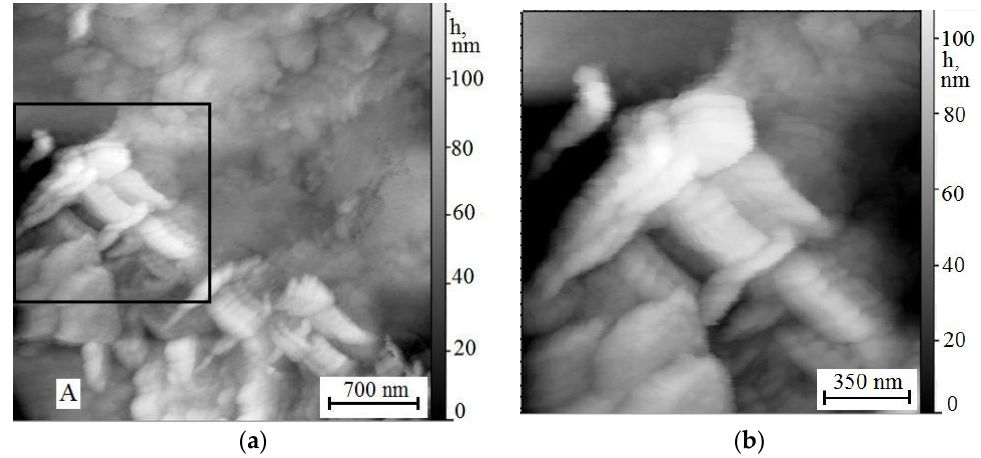
Figure 7. ( a ) STM image of the structure of the coating deposited with the experimental electrode containing 1% TiCN: ( b ) higher-resolution STM image of the region squared in Figure a. Acicular crystals have a rather uniform contrast in the STM images, which may indi- cate their homogeneous chemical composition, without precipitates, such as carbides.